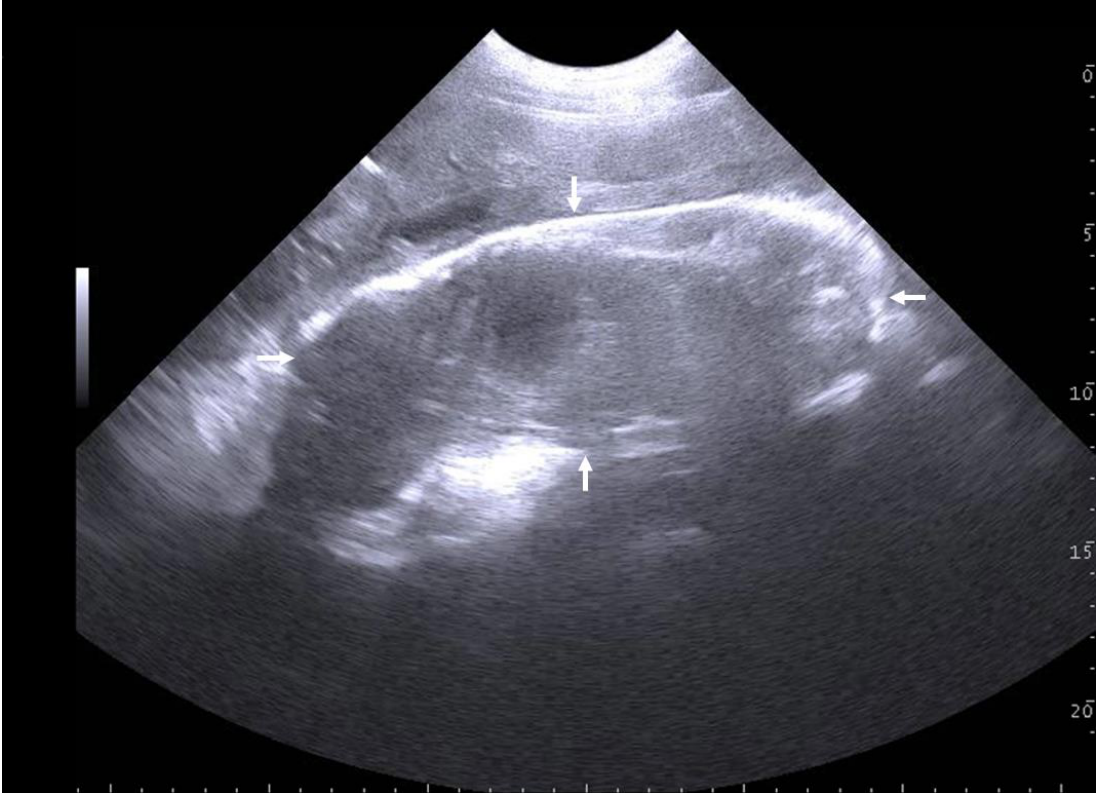
Figure 1. Transabdominal ultrasonographic image of a non-expelled dead piglet (arrows indicate vertical and horizontal dimensions) at examination 23 h 50 min after the beginning of farrowing. No heart beats could be detected. The sow had expelled 13 piglets and 4 placentae within 9 h 30 min, but then stopped farrowing. Post RTU and an additional vaginal examination, oxytocin was given and the retained dead piglet including the placenta expelled within 20 min. Scale bar on right margin in 1.0 cm steps. (Courtesy of Alexander Grahofer, Bern, Switzerland).